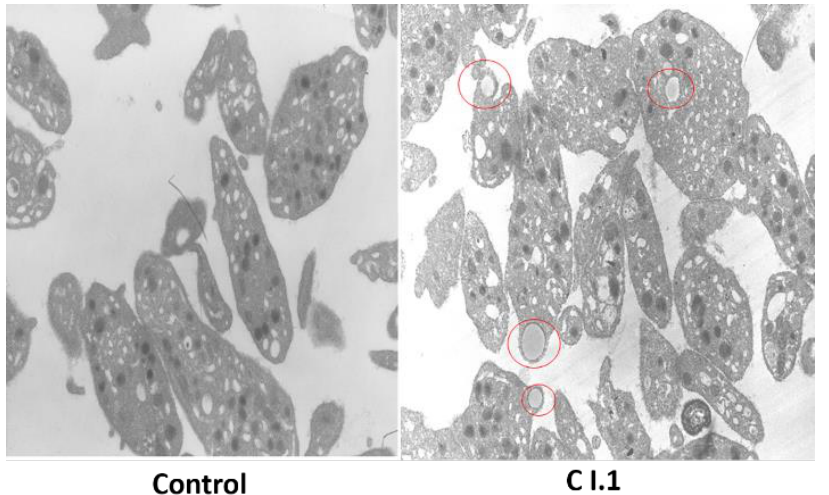
Figure 5. Platelet electron microscopy for the Spanish patient. Platelet electron microscopy could be performed once in the Spanish index case. Similar, or slightly reduced, numbers of alpha and dense granules are seen in the patient vs. control. C I. 1′ s platelets also show larger vacuole-type structures (red circles) which contain material, so they are not likely a part of the open canalicular system.